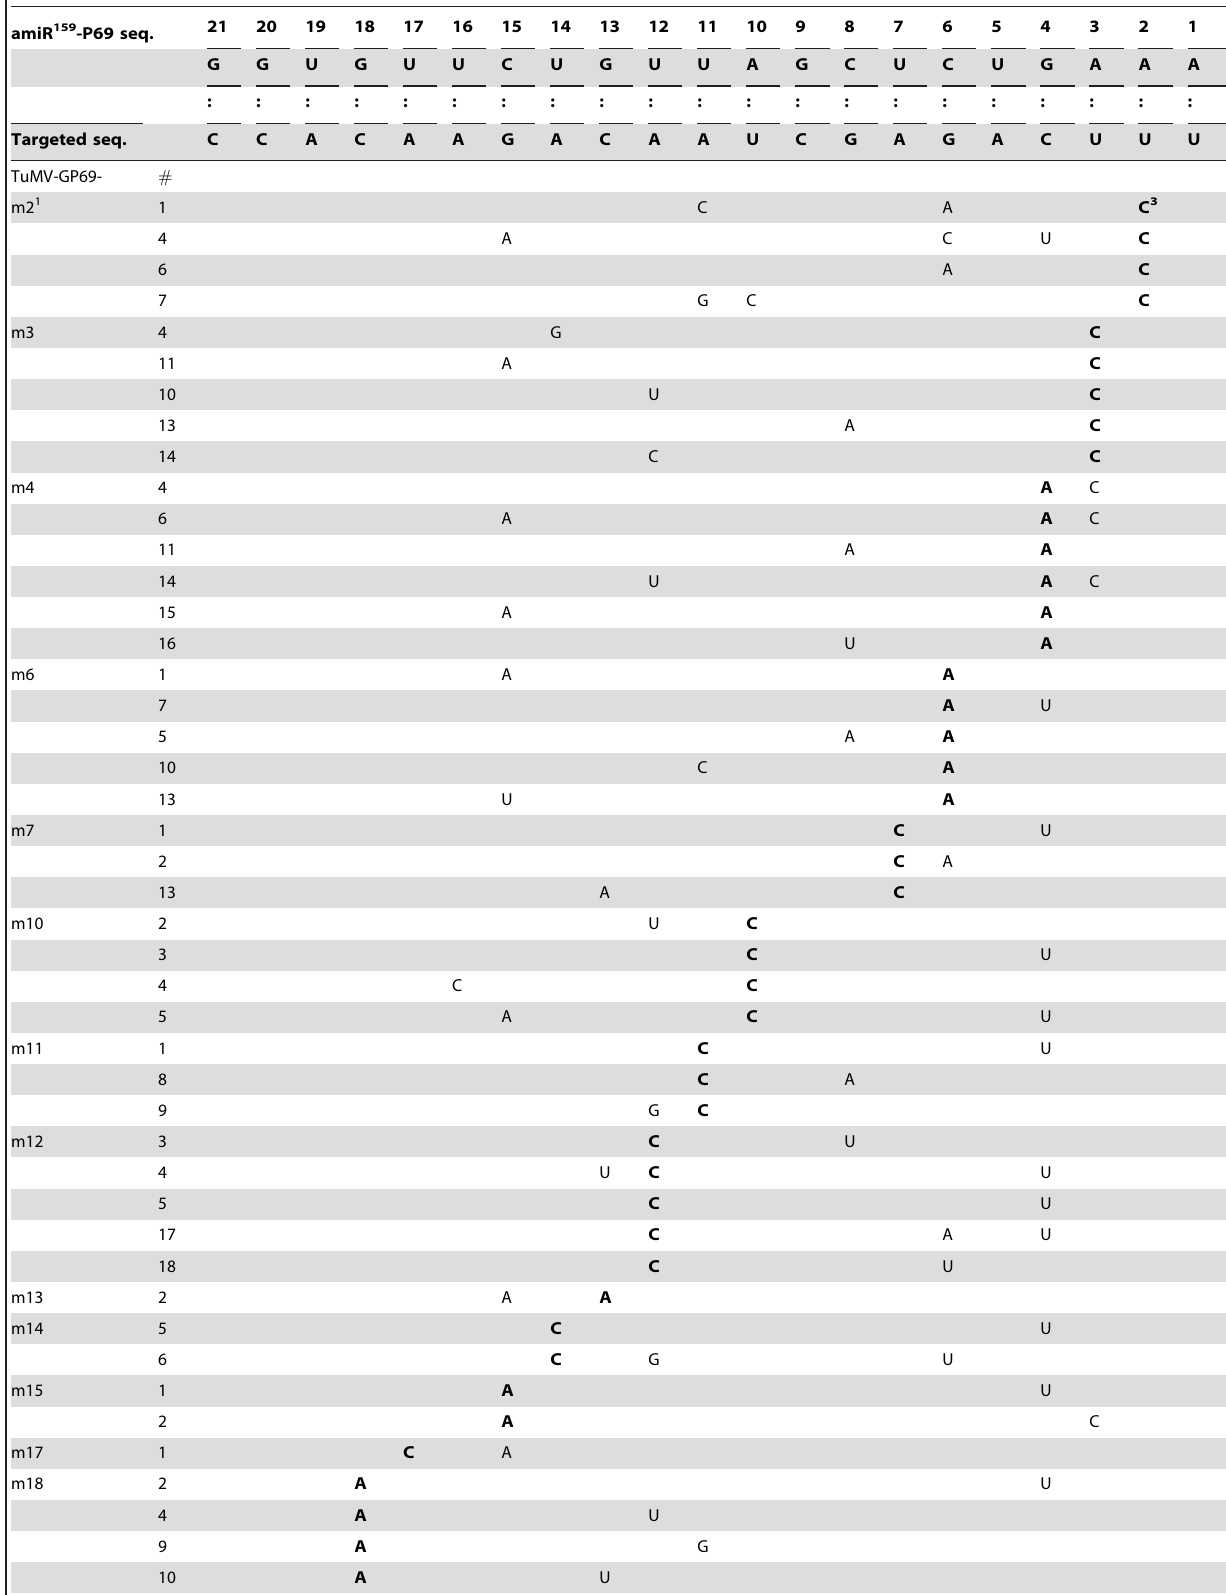
Table 2. Additional mutations on the 21-nt target fixed during virus evolution.